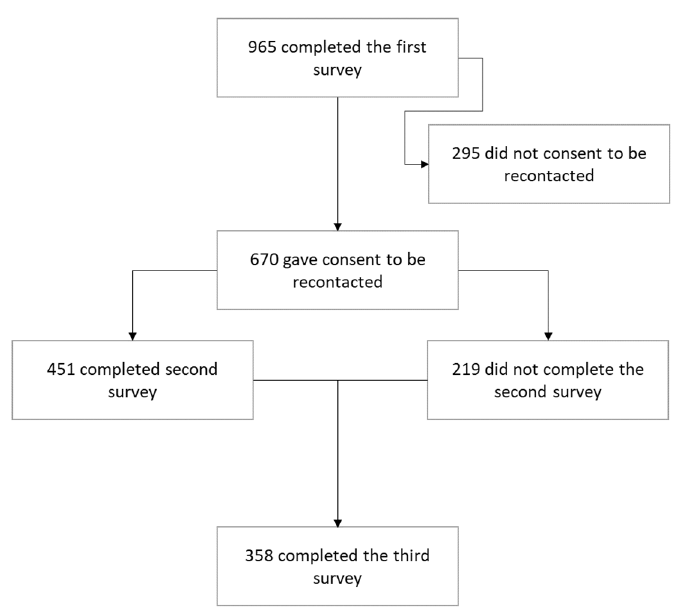
Figure 1. Flow of participants through the EWFH study.